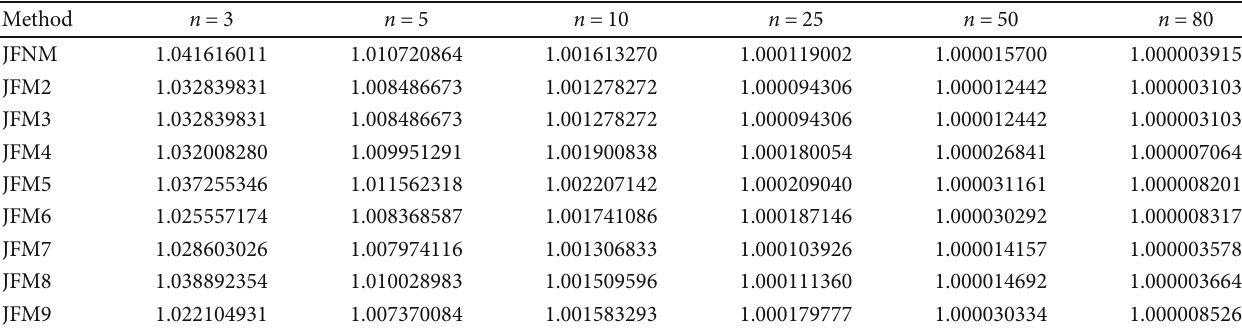
n = 3, 5, 10,25,50,80